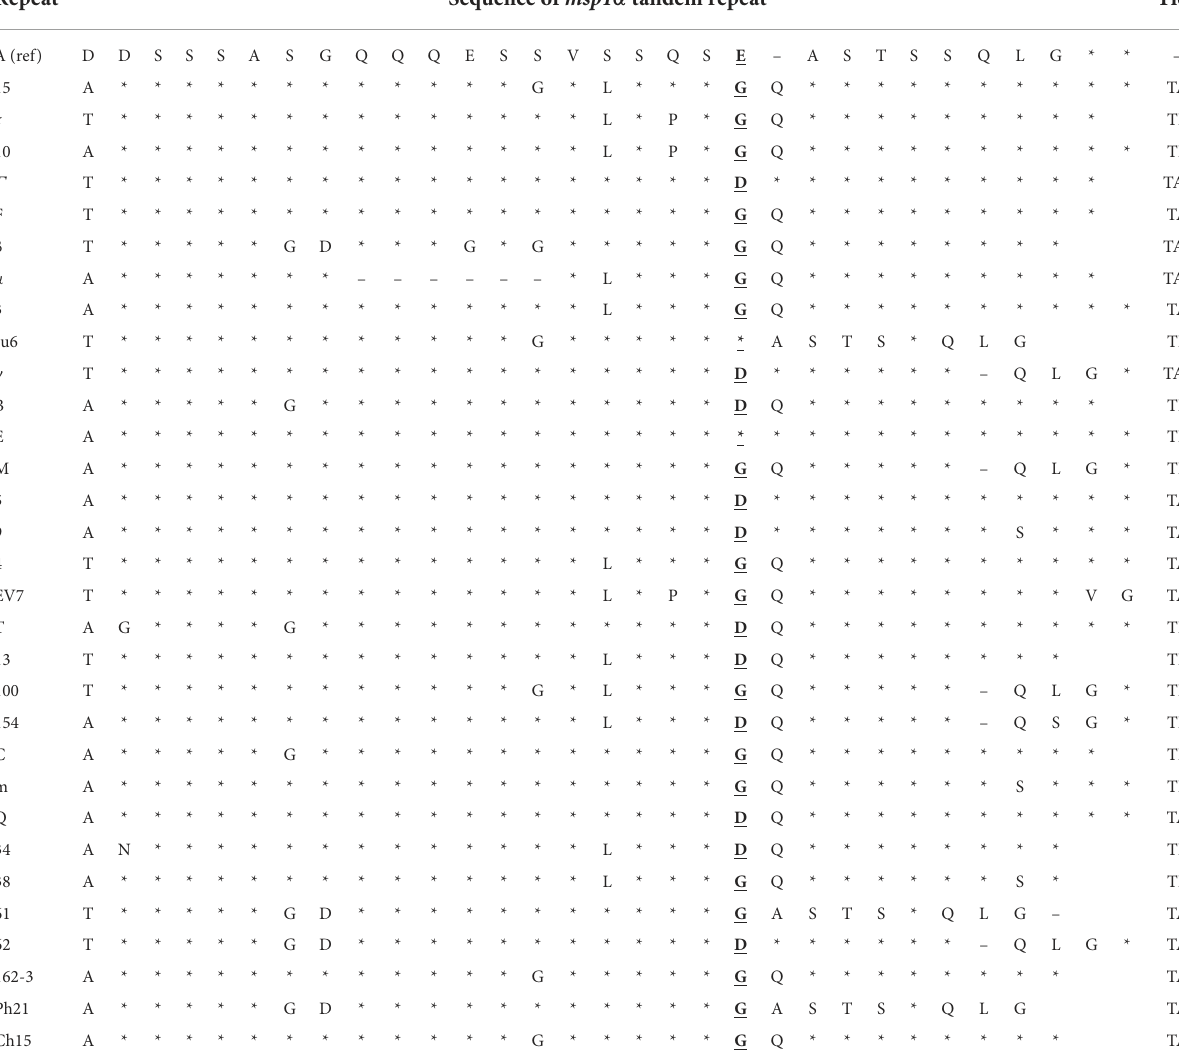
TABLE 1 Sequence of MSP1a tandem repeats found in the Anaplasma marginale strains of this study, ordered from highest to lowest presence. Repeat Sequence of msp1 α tandem repeat Tick A